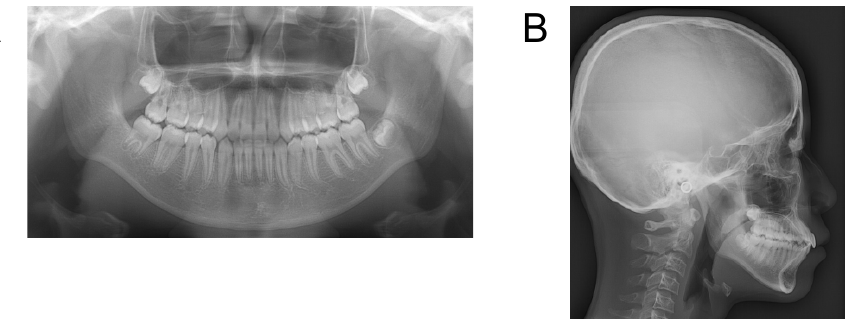
Figure 10. Facial photograph and intra-oral photograph of Case 2 at the end of the first stage of treatment; facial photograph and enlarged photograph of the mouth at the end of the first stage of treatment ( A ); intra-oral photograph at the end of first stage of treatment ( B ).